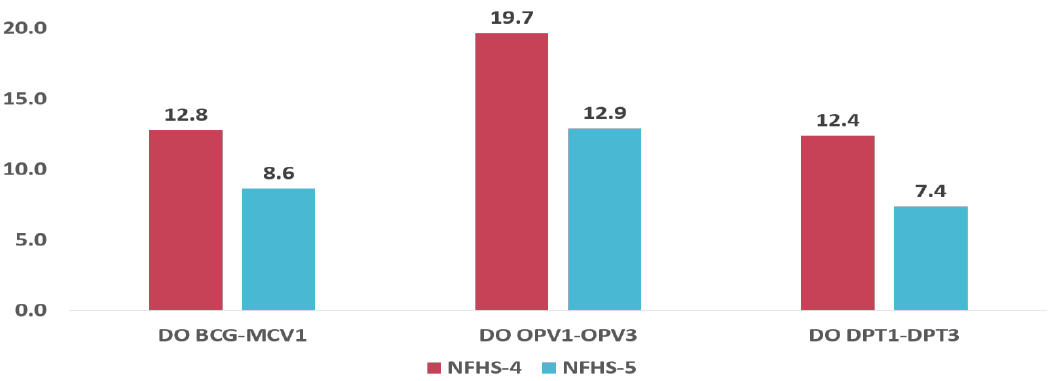
Figure 3. Antigen wise dropout rate in NFHS-4 and NFHS-5.